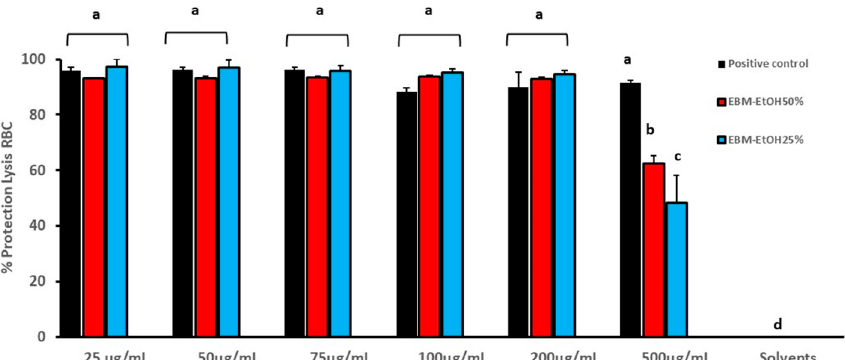
Figure 3. Anti-inflammatory activity of EBM-EtOH25% and EBM-EtOH50% by red blood cell membrane stabilized (RBC) assay. The results for positive control (diclofenac) and negative control solvents (EtOH25% and EtOH50%) can be seen. Results are presented as Mean ± SD ( n = 3) and were evaluated by one-way Anova and Tukey test ( p < 0.05). Statistical differences are indicated with different letters.